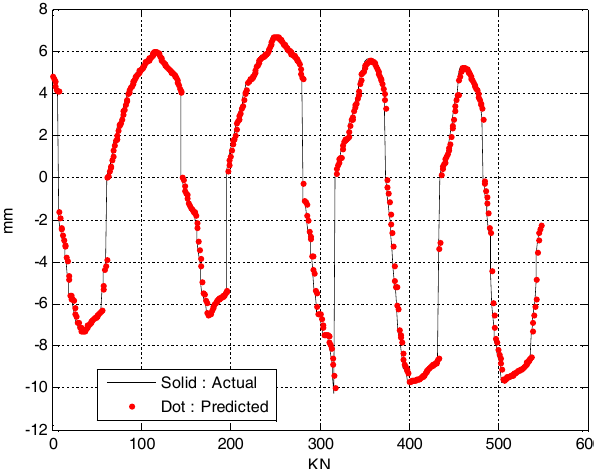
Figure 8. Training for no-fines lightweight concrete wall without the horizontal reinforcement.